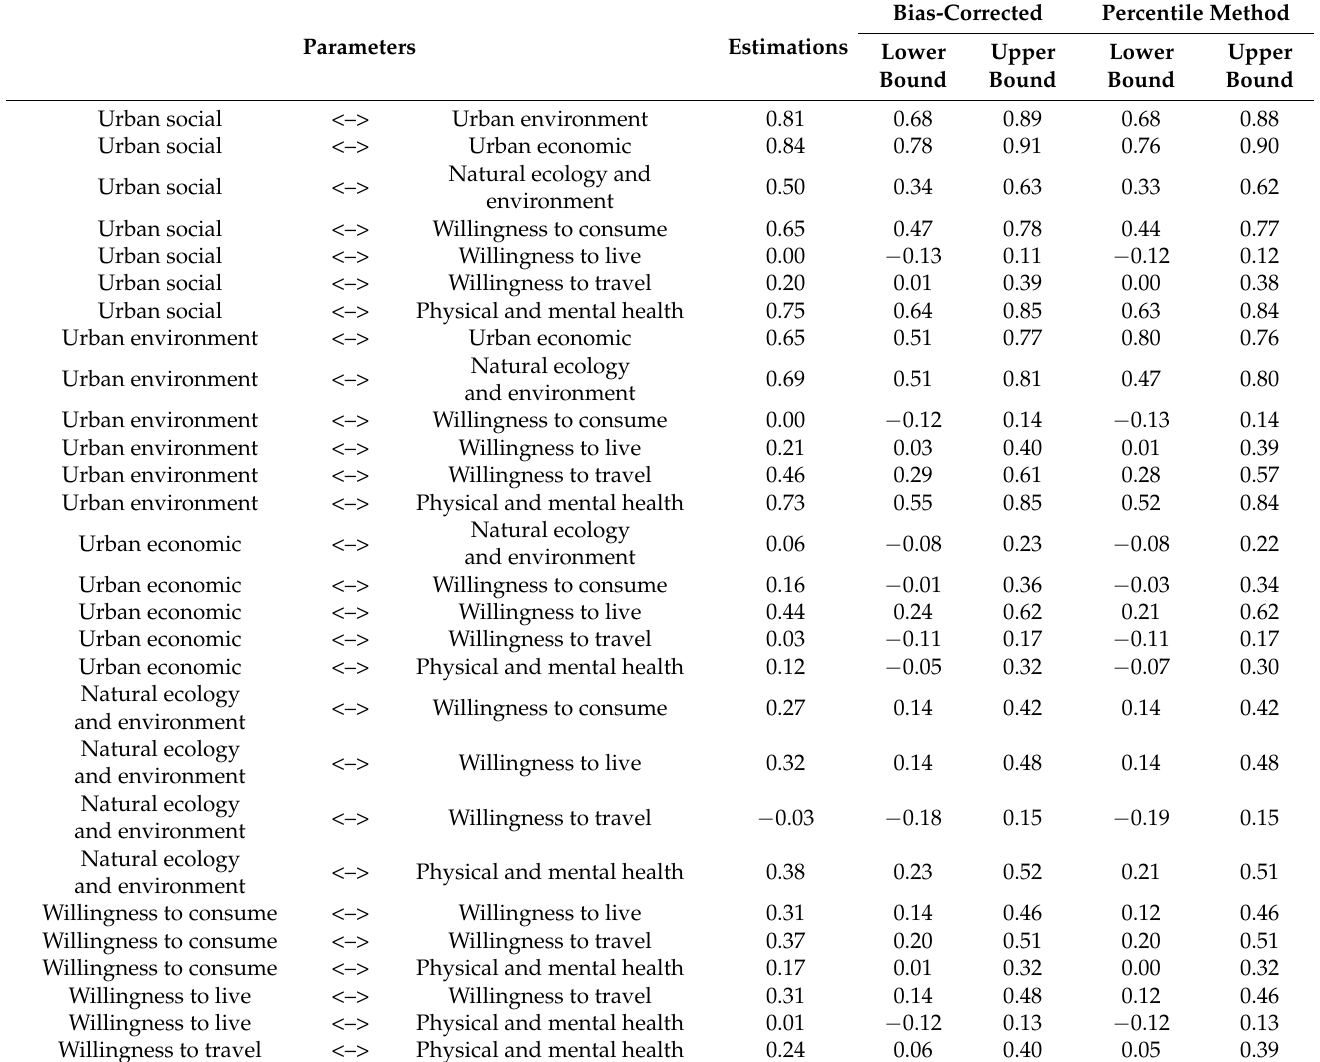
Table 3. Bootstrap correlation coefficient 95% confidence interval